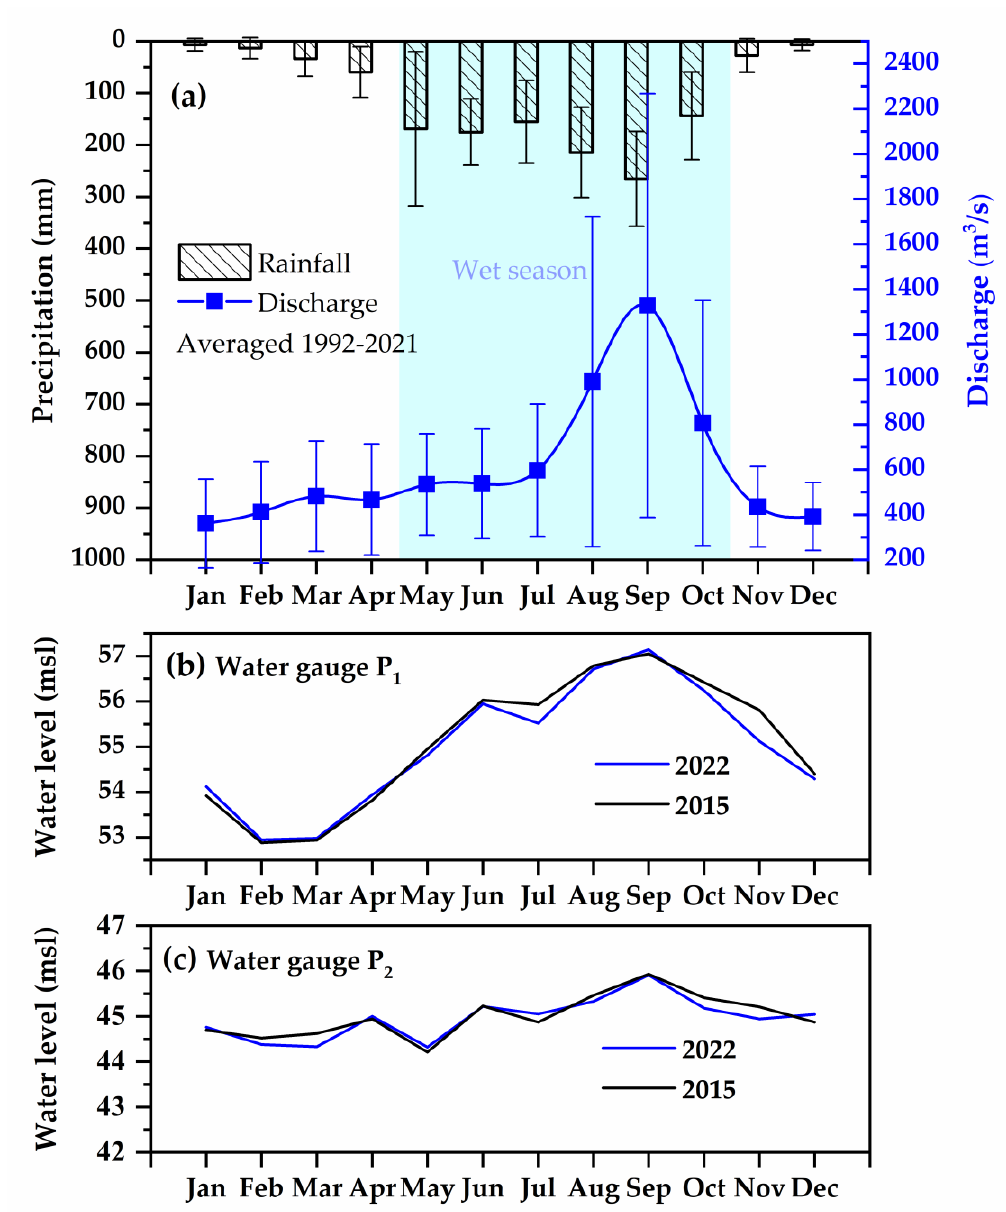
Figure 3. ( a ) Long-term (1992–2021) average rainfall (mm) and river discharge (m 3 /s) in the Ping River basin showing wet (light blue) and dry seasons, ( b ) water levels (msl) in 2015 (black line) and 2022 (blue line) at station P 1 , ( c ) water levels (msl) in 2015 (black line) and 2022 (blue line) at station P